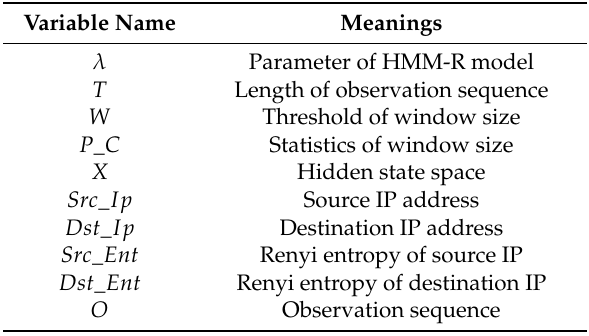
Table 1. Meaning of the variable names in the HMM-R detection